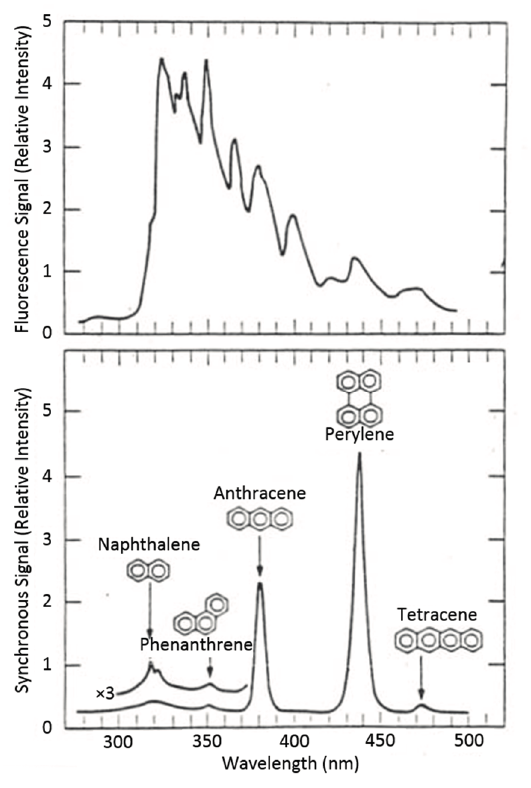
Figure 1. Conventional fixed-excitation fluorescence of a five-component mixture (upper curve, 258 nm excitation) and the SF spectrum of the same mixture showing improved spectral component separation (lower curve, 3 nm wavelength interval). Adapted from